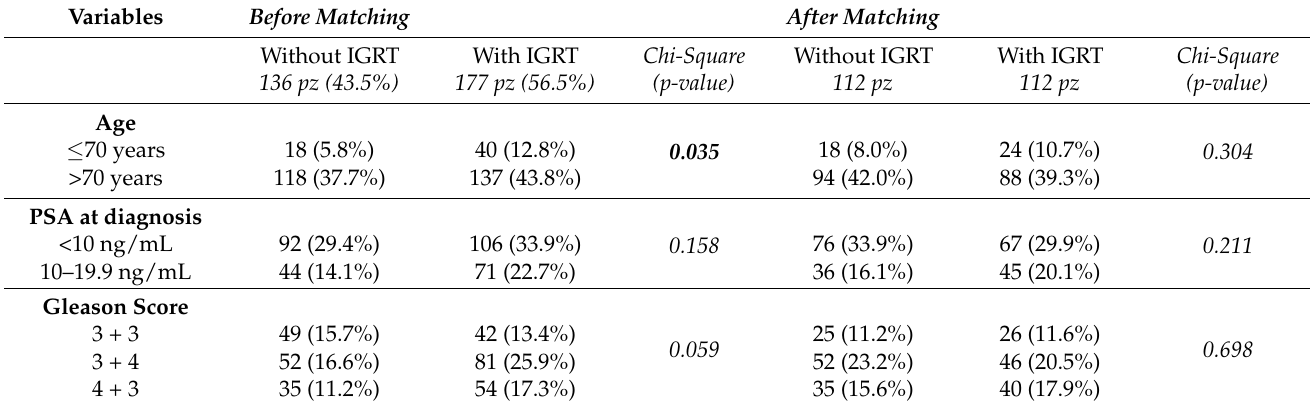
Table 2. Patient and tumor characteristics before and after propensity score